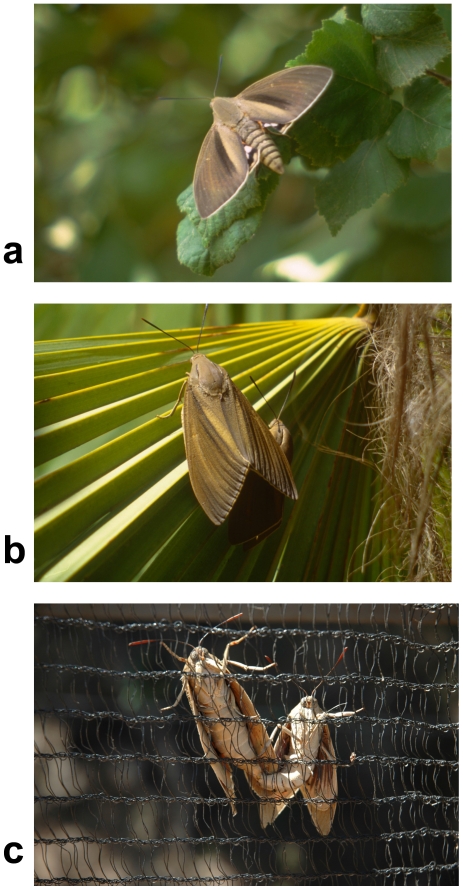

Paysandisia archon courtship:
a. A perching male of P. archon about to take off for an intruder (Courtship step 1); b. Male orienting himself and approaching the female from below, just after the alighting of both specimens (Courtship step 3); c. Pair in copula. The male, on the right, keeps his abdomen bent and attached to that of the female (Courtship step 6).